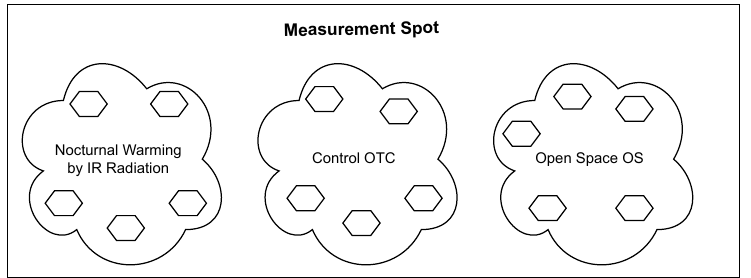
Figure 2. The main diagram of the experimental setup organized by three main groups. Each group contains five OTC, where six plants are monitored (three DA and three